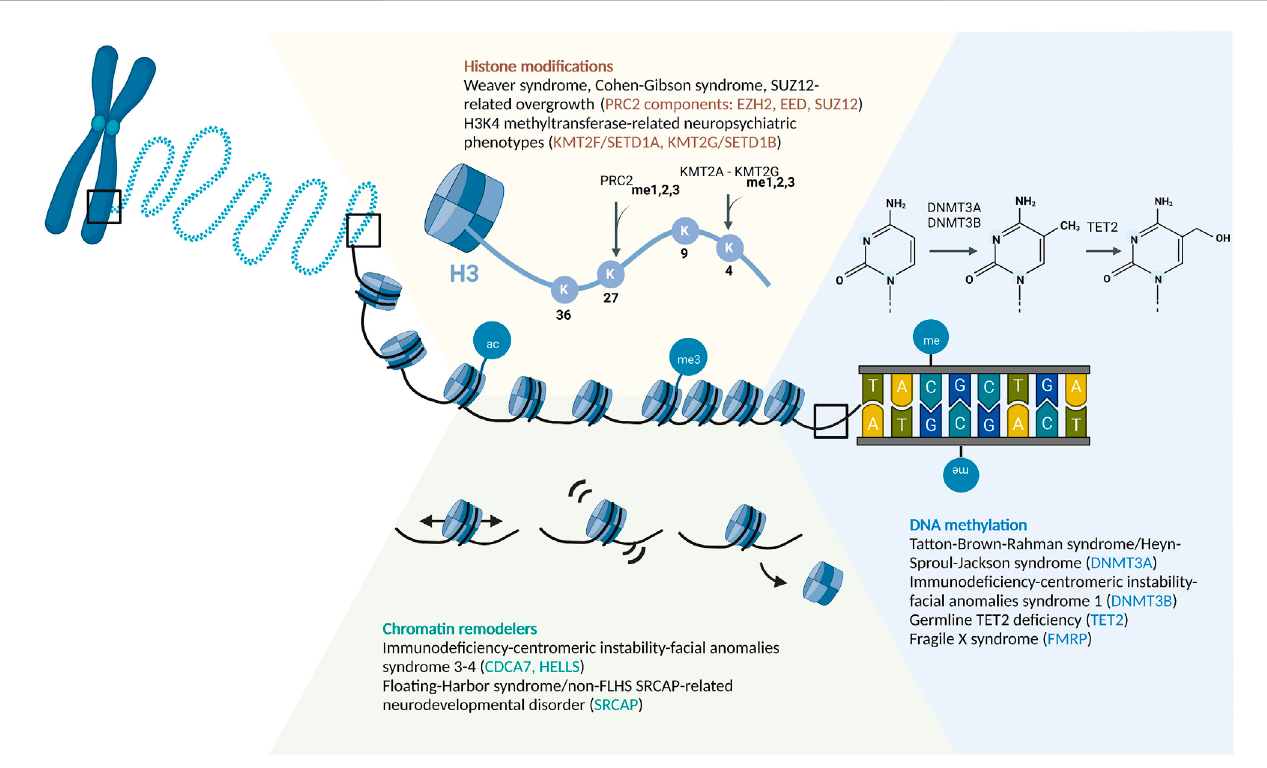
FIGURE 1 Schematic of Epigenetic Regulatory Mechanisms Associated With RDEOs: Chromatin Remodelers, Histone Modi fi cations, and DNA Methylation. Abbreviations: ac, acetylation; me, methylation.